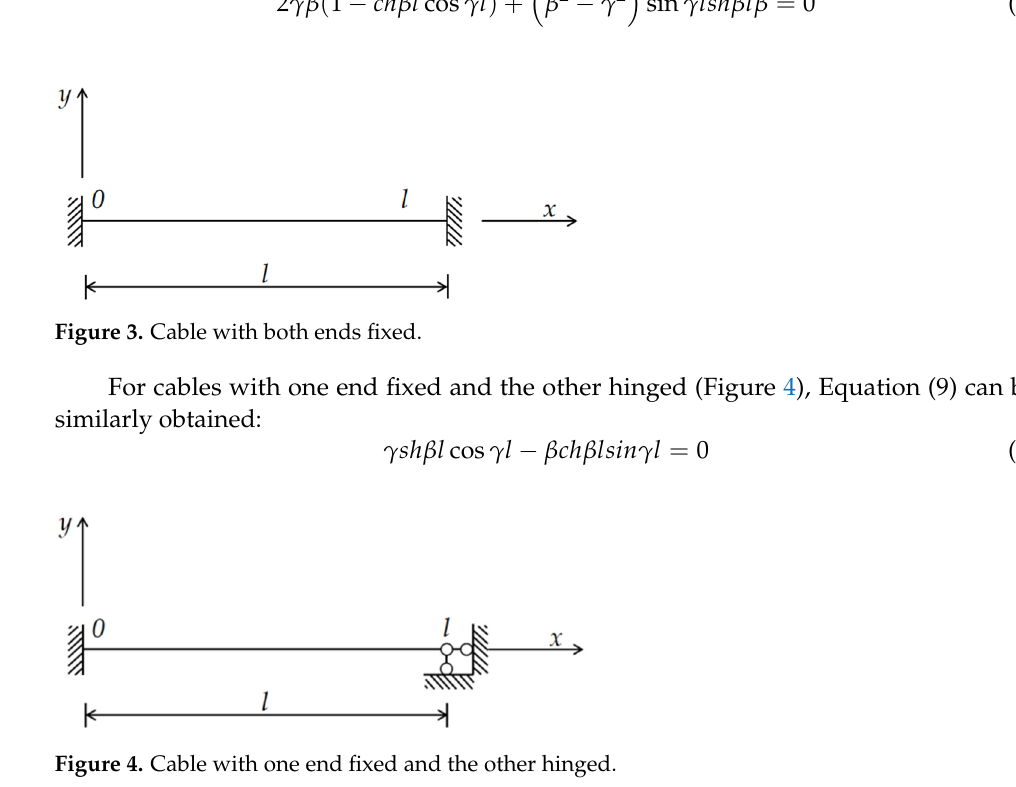
Figure 4. Cable with one end fixed and the other hinged.